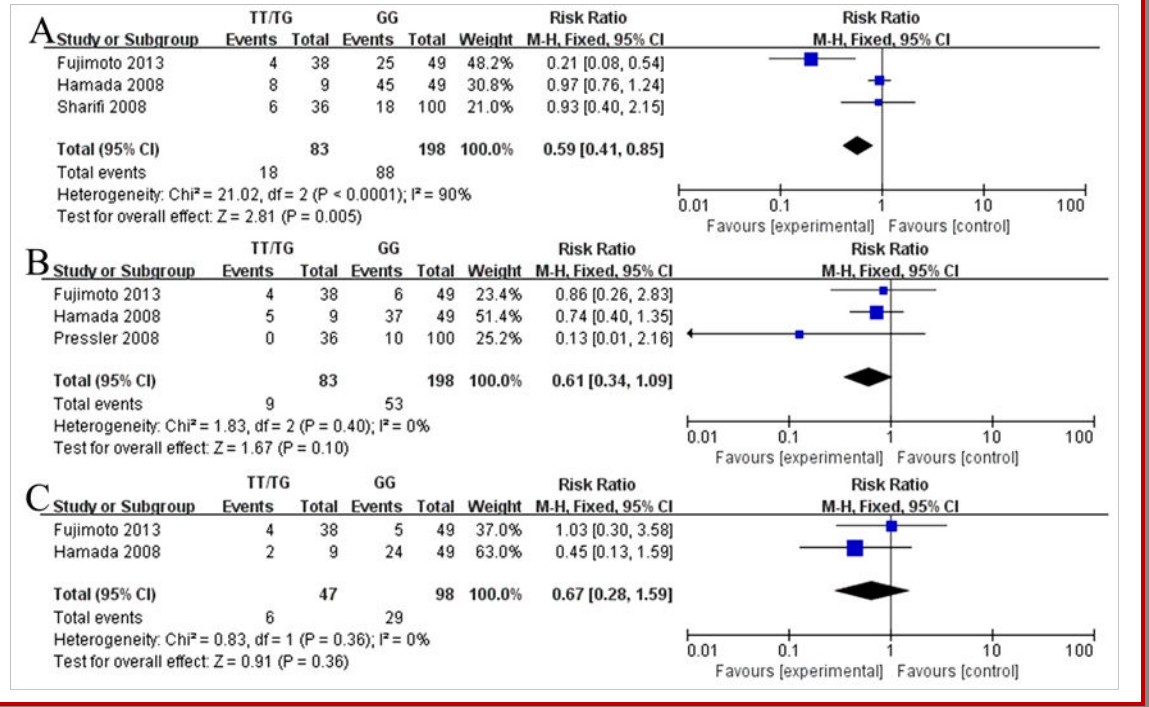
Figure 3: Association between the mutation rate of SLCO1B3 (rs4149117) and recurrence-free survival of prostate cancer 2 years RFS (A), 5 years RFS (B), and 10 years RFS (C) of prostate cancer TT, rs4149117 TT; TG, rs4149117 TG; GG, 4149117